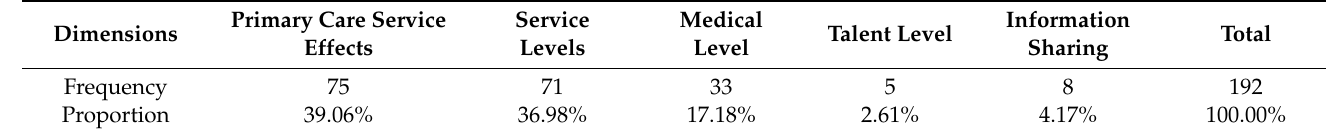
Table 2. Dimensions and